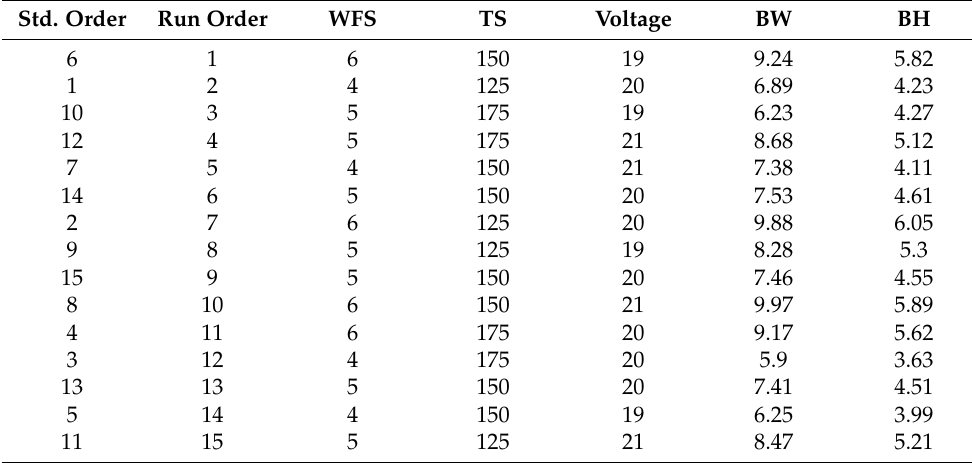
Table 3. Design variables of WAAM process with measured